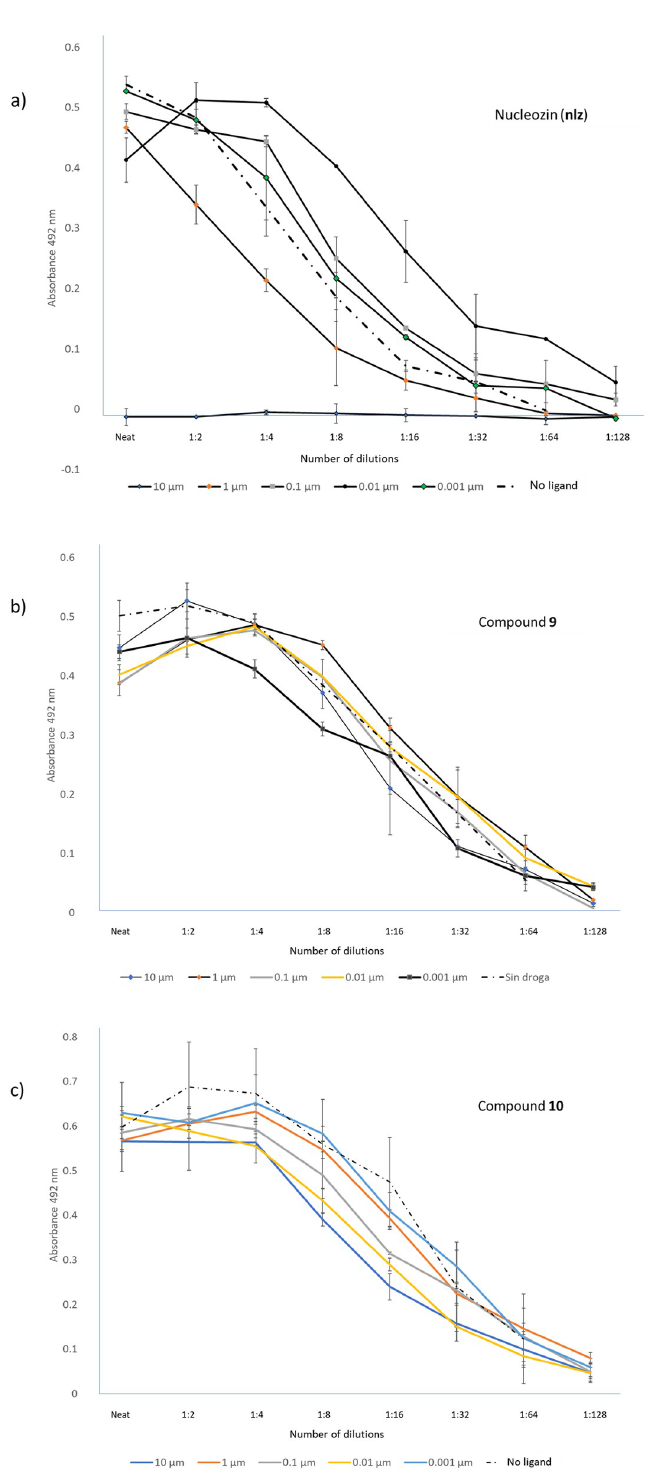
Fig 8. Biological evaluation of nlz and analogs in cell cultures of influenza virus-infected MDCK cells. The experiments were performed by infecting MDCK cells with the Influenza virus A/Caledonia H1N1, at a concentration of 0.001 pfu per cell in presence of various concentrations of nlz or analogs. After 48 hrs of incubation, the supernatants were obtained and titrated in MDCK cells and incubated for 72 hrs. Cells were fixed-permeabilized and an ELISA on the cells performed, using an anti- influenza M1 monoclonal antibody, followed by a goat anti-mouse Ig’s